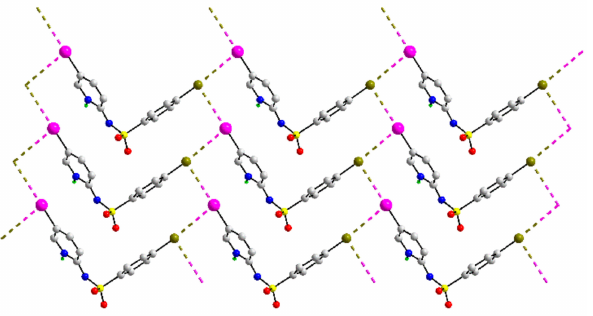
Figure 11. A view of the two-dimensional array in the crystal of 40 .